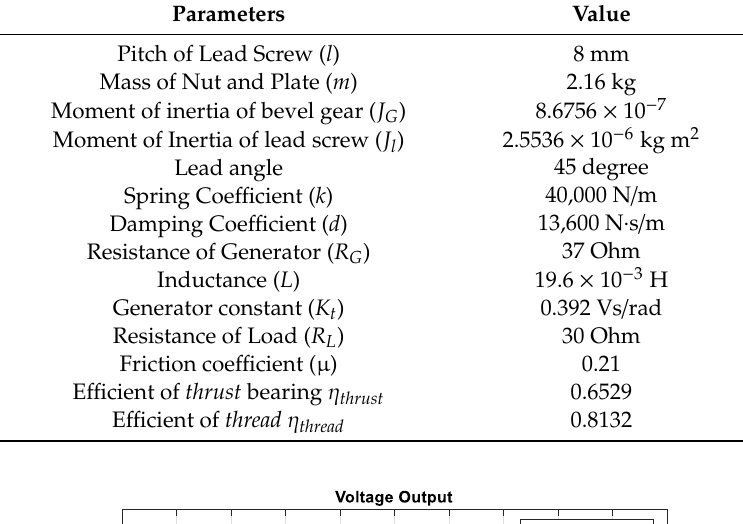
Table 2. Lead-Screw Parameters.